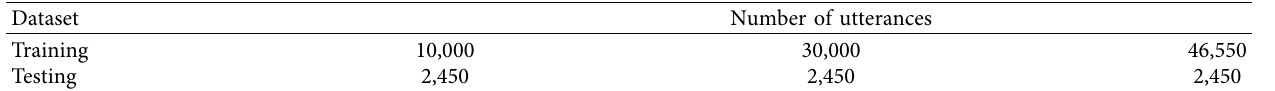
Table 7: Three different sizes of training